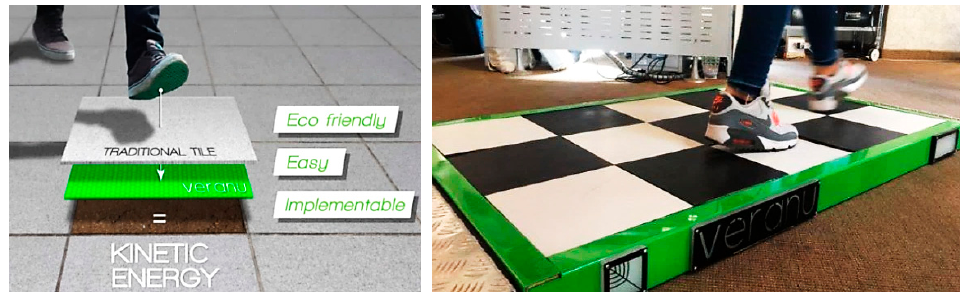
Figure 36. Veranu piezoelectric tile [86].